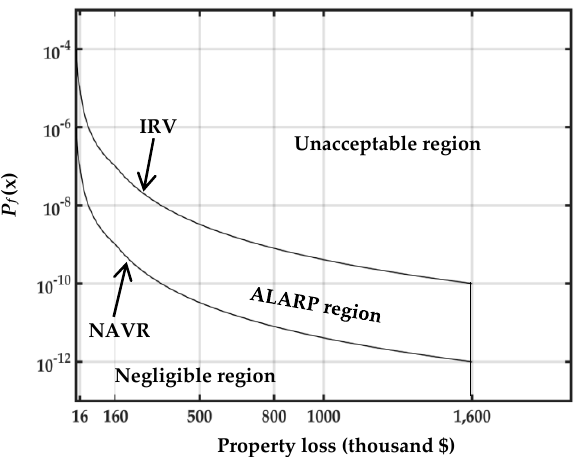
Figure 6. Pipeline property loss risk acceptable